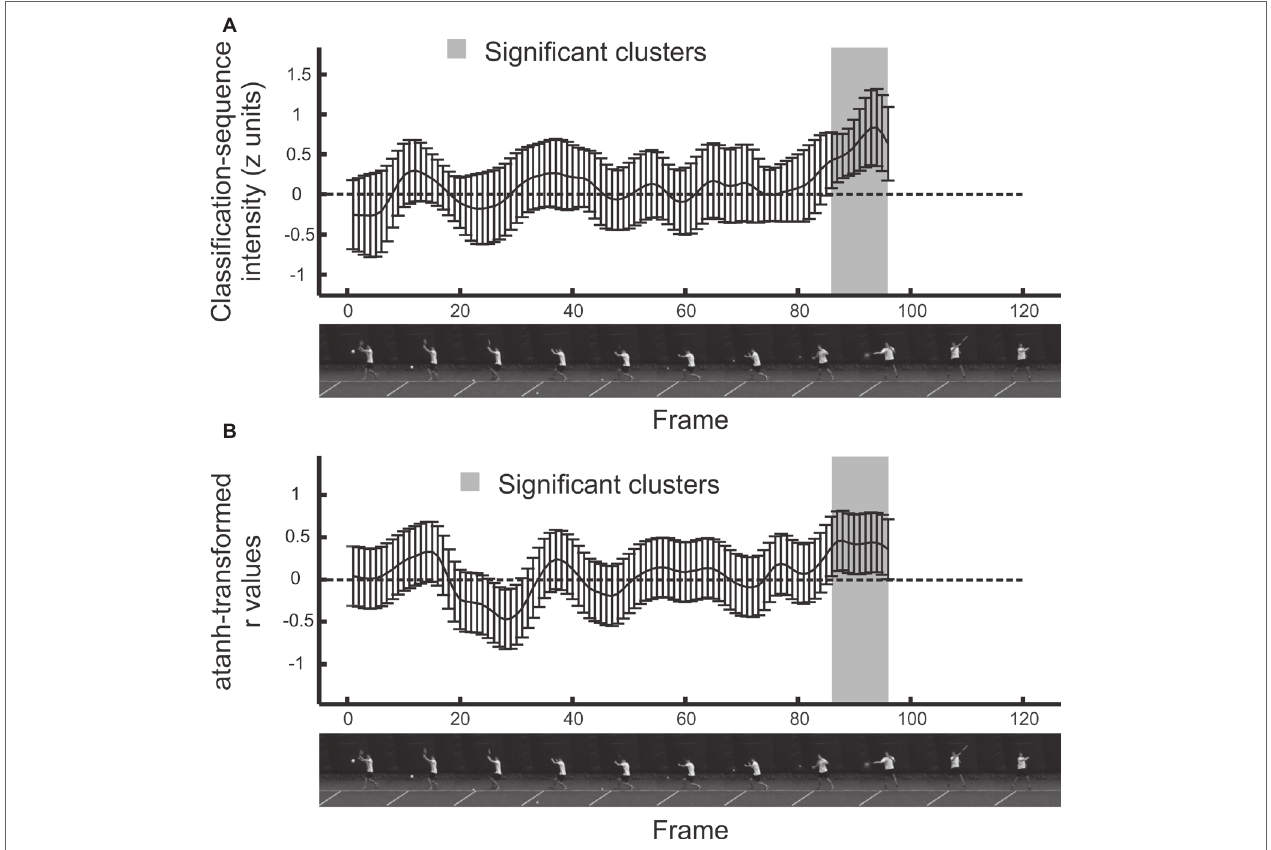
FIGURE 2 | Results from temporal bubbles experiment. Error bars denote 95% confidence intervals. Shaded regions denote significant clusters. (A) Mean z -scored classification sequence. (B) Correlations between classification sequences and classification performance across